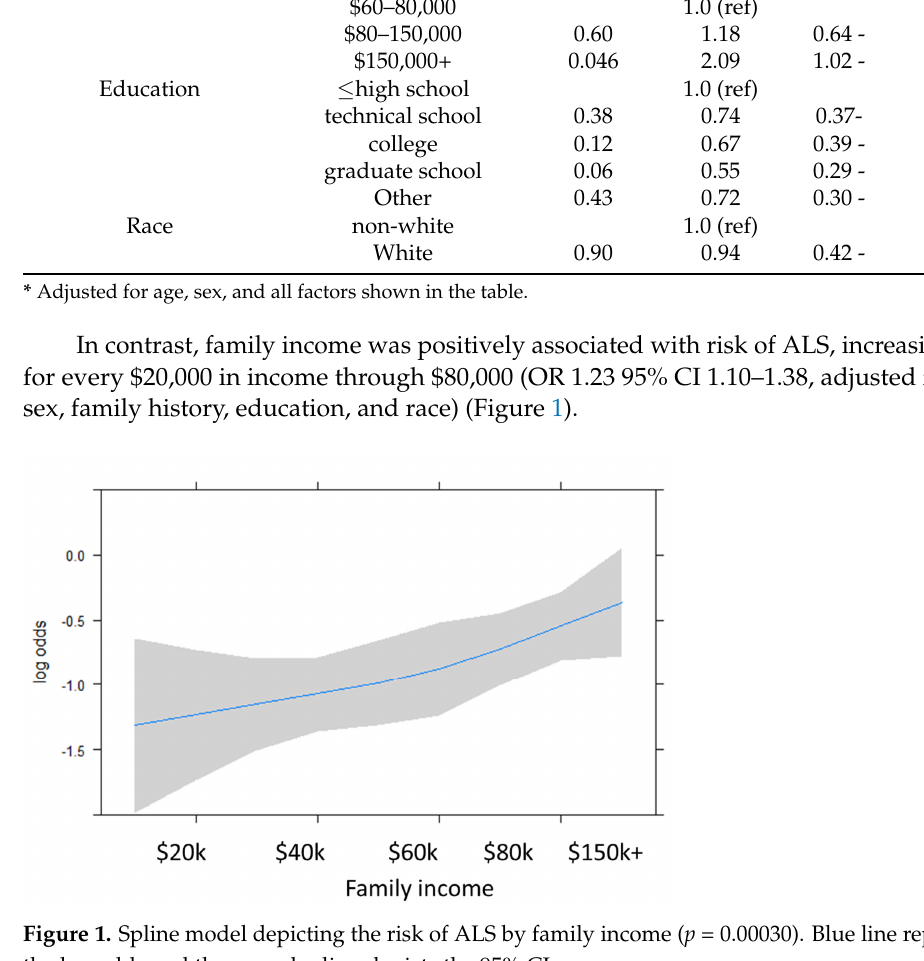
Table 2. Multivariable model of demographic/lifestyle factors and ALS risk. Multivariable Model